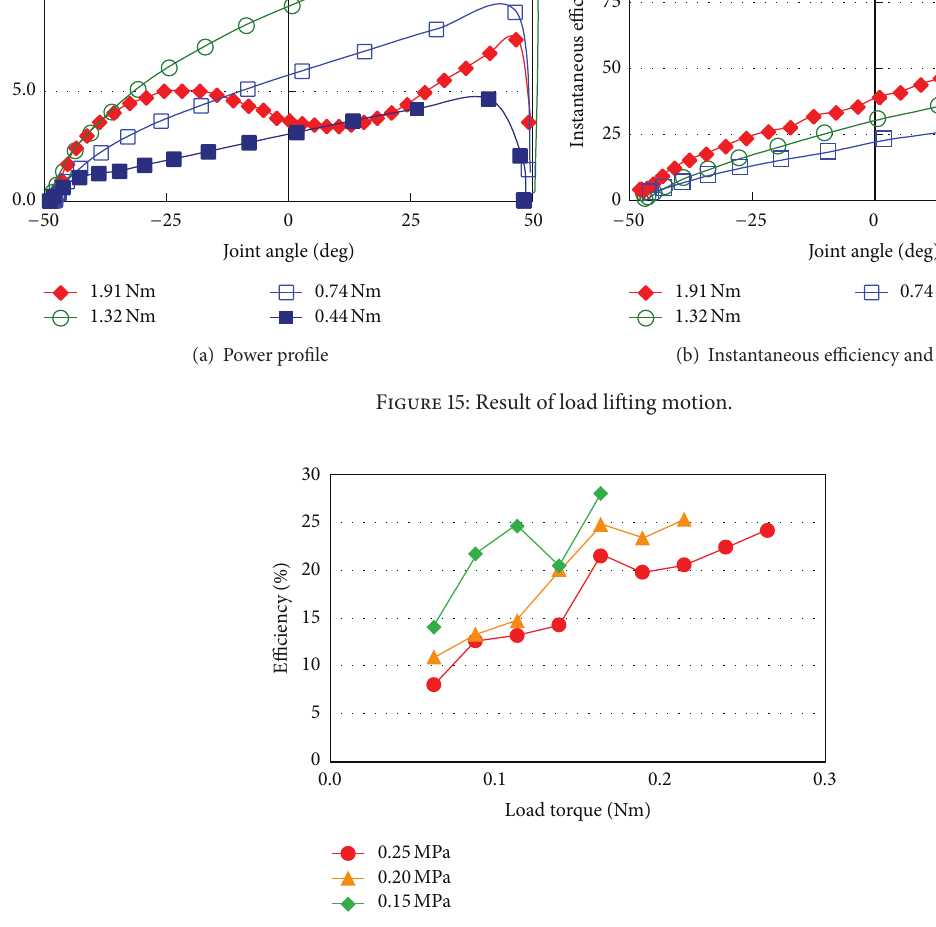
Figure 16: Efficiency dependency on the load